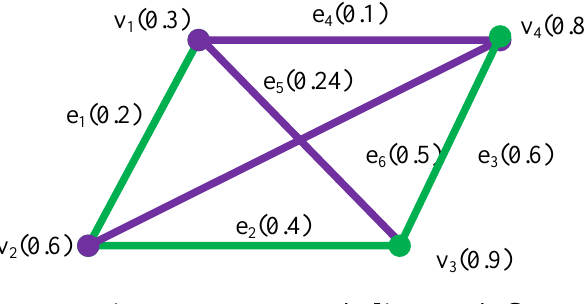
Figure 3.2: Fuzzy Labeling graph